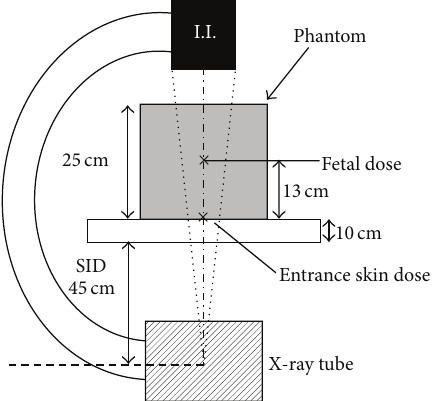
Figure1:Schematicoftheacrylicphantomusedtosimulatethefetal radiation dose in the angiography suite. FDP, flat-panel detector; SID, source-image distance.